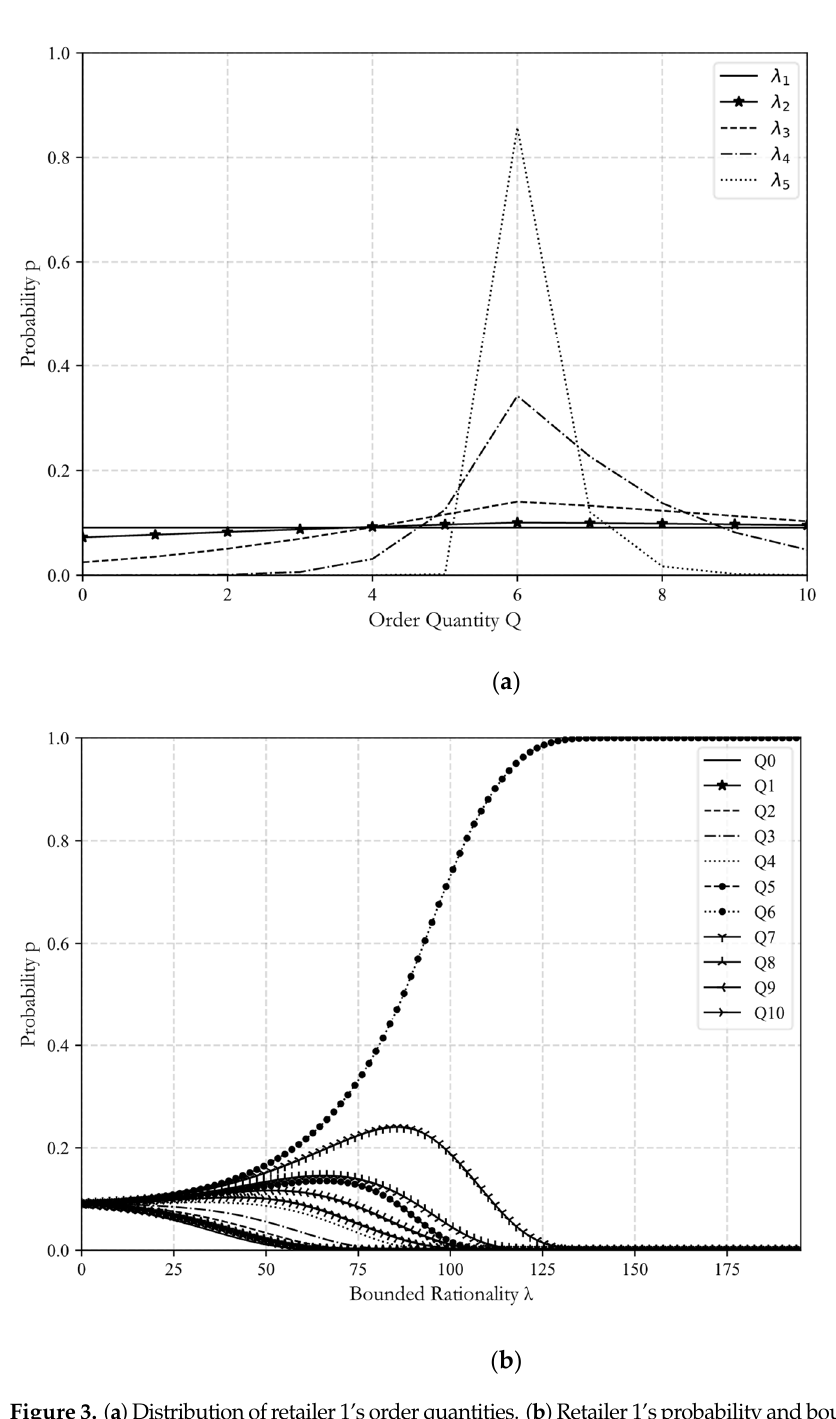
Figure 3. ( a ) Distribution of retailer 1’s order quantities. ( b ) Retailer 1’s probability and bounded